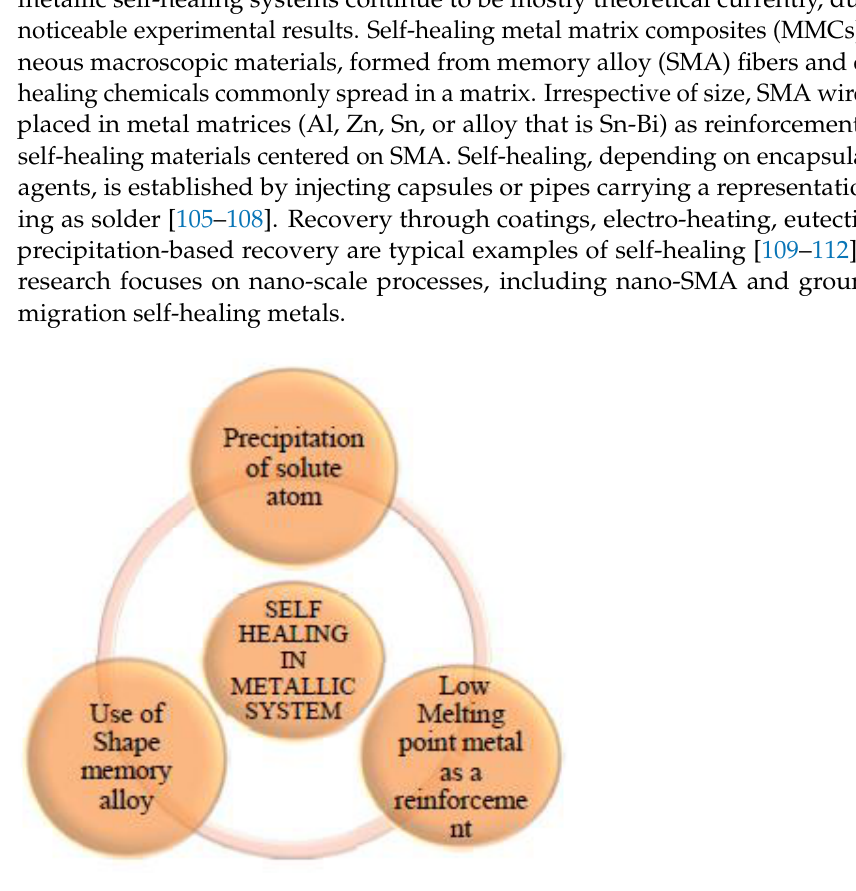
Figure 10. Methods of self-healing metals